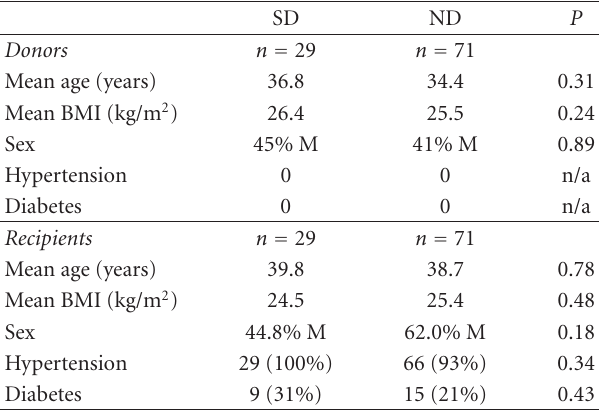
Table 1: Demographics and preoperative characteristics of 200 patients at a single institution, including 100 kidney donors undergoing laparoscopic donor nephrectomy as well as their 100 recipients. Patients were stratified by donor tobacco history into those with a history of tobacco use (SD) and a control group with no history of tobacco use (ND).